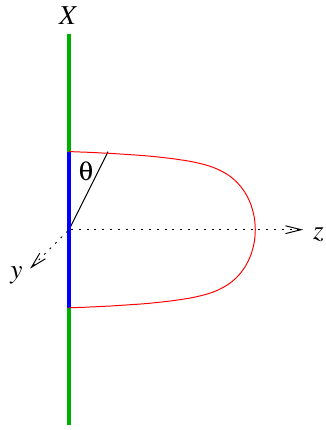
Figure 7 . Ryu-Takayanagi surface parametrized as a function X ( θ, y ) in red. The y direction is periodic. The fact that the Ryu-Takayanagi surface is extended in the y direction is implied. Here, z = e − φ + φ 0 and z = 0 is the